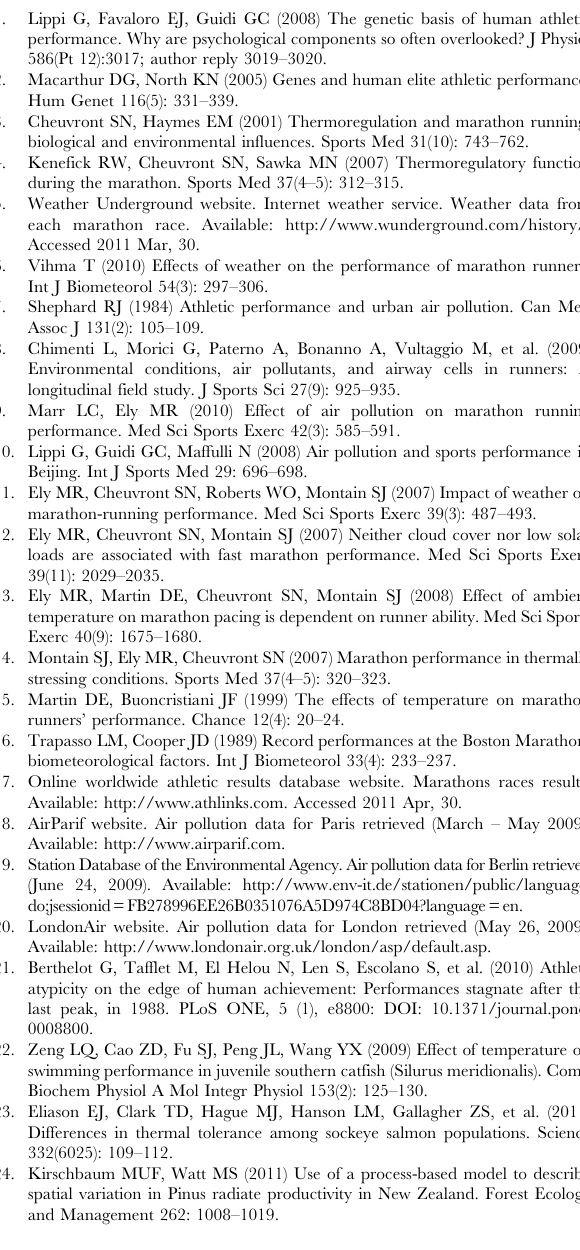
Table S1 Time values of different descriptive statistics